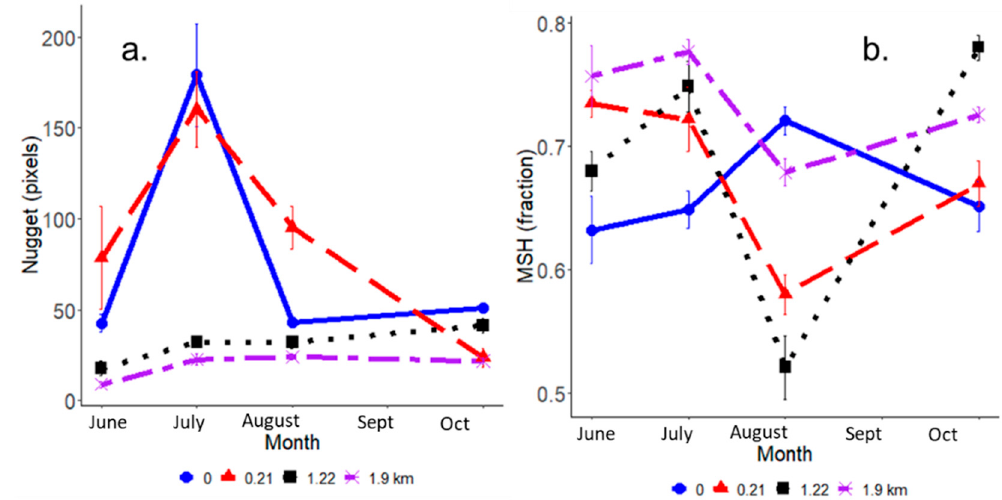
Figure 6. IRIS derived patterns in the ( a ) nugget (pixels) and in the ( b ) fractional value of the magnitude of spatial heterogeneity across distance in the wetland (km) and by month. Nugget values are calculated as a mean of 25 replicate semivariograms from each site and depth. The MSH is a summary statistic based off the geostatistical parameters. When the MSH equals 1, the site is completely heterogeneous. Error bars denote standard errors.